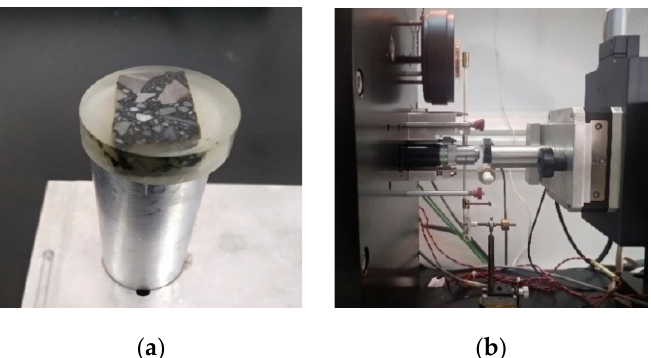
Figure 4. Sample used for the nanoindentation. ( a ) Test sample after the smoothing process, ( b ) the nanoindentation test.